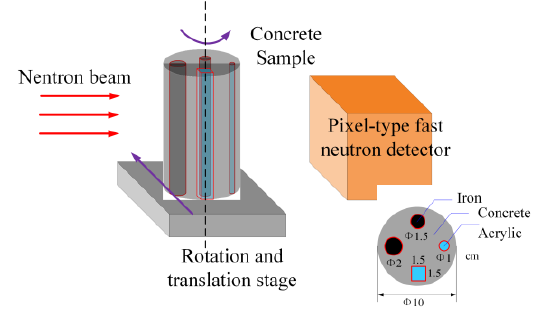
Fig. 5. Fast neutron CT setup